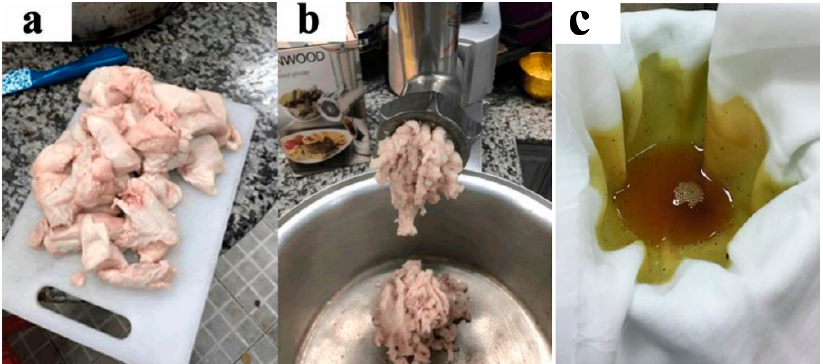
Figure 3. ( a ) Sheep fat chopped; ( b ) the fat minced to small pieces by mincing machine, ( c ) the process of fine filtration of crude oil.